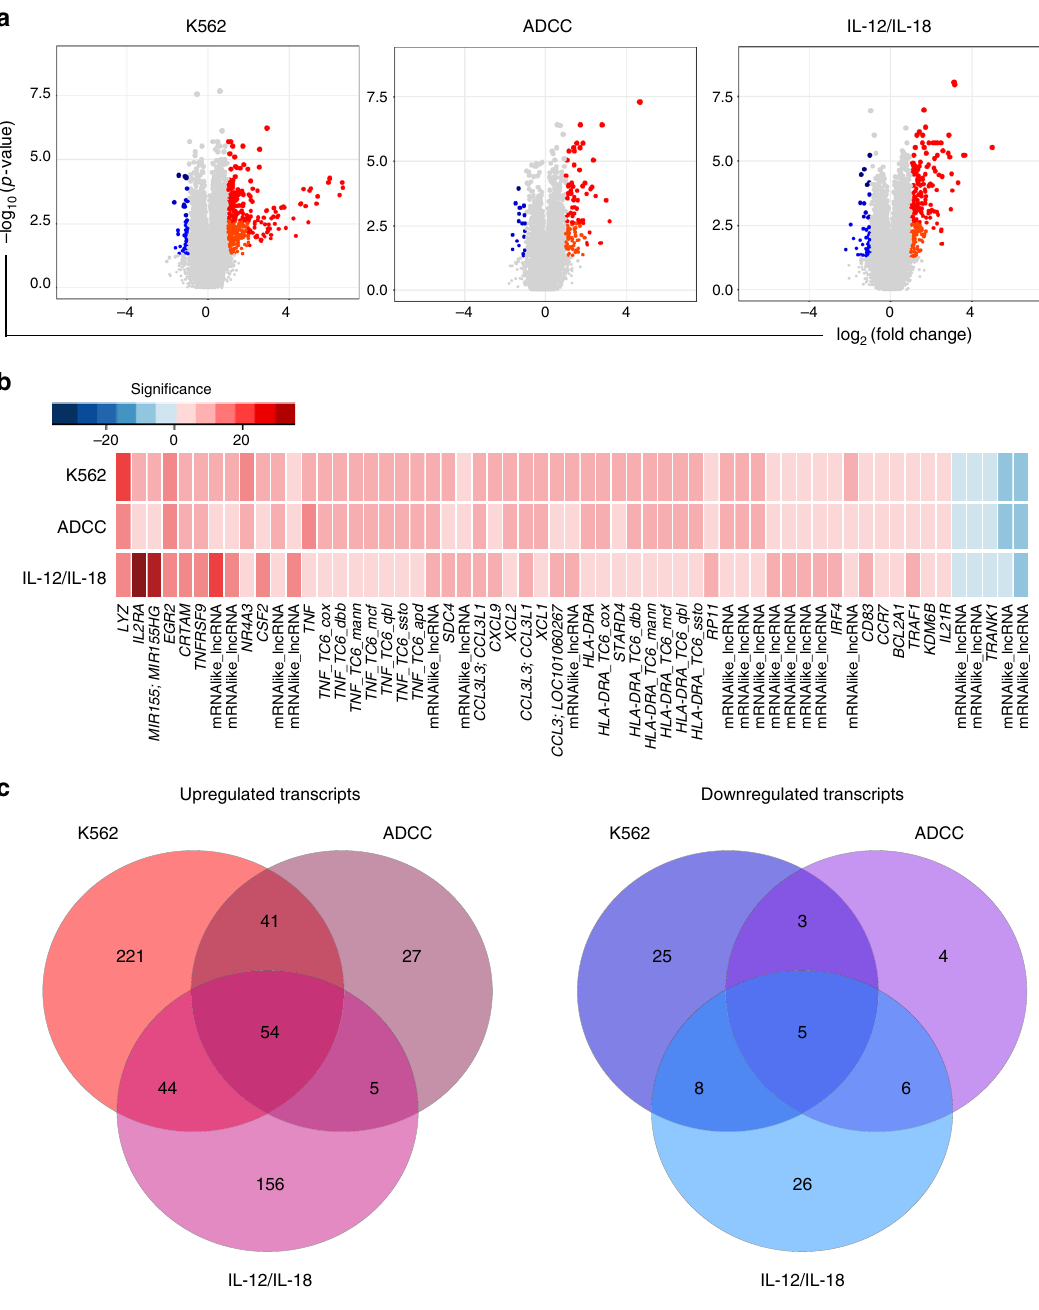
Fig. 2 Whole-transcriptome analysis of functional NK cells. a Volcano plots representing upregulated and downregulated transcripts of functional NK cells in response to different stimulation conditions. Size of each data point is calculated as − log 10 ( p -value) × log 2 (FC), p -value cutoff p < 0.05, fold change cutoff > 2 or <1/2. Red dots represent upregulated transcripts, blue dots represent downregulated transcripts. b Heat map comparison of common gene expression signi fi cance values ( − log 10 ( p -value)) across three stimulation conditions. c Venn diagrams displaying upregulated (red) and downregulated (blue) transcripts of functional NK cells across three stimulation ranked pathways within cytokine stimulation include NAD and pyruvate metabolic process, positive regulation of protein kinase b signaling, and amino-acid transmembrane transporter activity with NES values ranging from 1.8 to 2.02 and FDR q -value < 0.01. All pathways, NES values, and FDR q -values are listed in sup- plementary data 4. cell, 100-cell, and bulk-cell levels (supplementary Fig. 3). Inter- estingly, CCL4 , which encodes beta chemokine MIP-1B, and IL2A , the gene encoding the alpha chain of the IL-2 receptor, gene expression was upregulated and detected only at the single- and